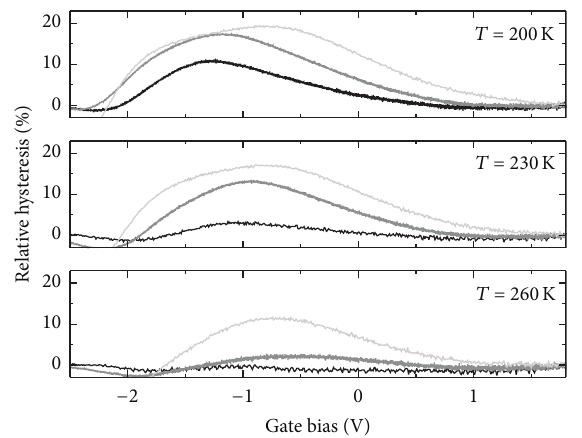
Figure 5: Relative hysteresis opening (with respect to the upper curve in Figure 3) as a function of temperature. A clear hysteresis can be seen up to a temperature of 290K. The room temperature storage time of holes in the QDs can be estimated to be in the range of